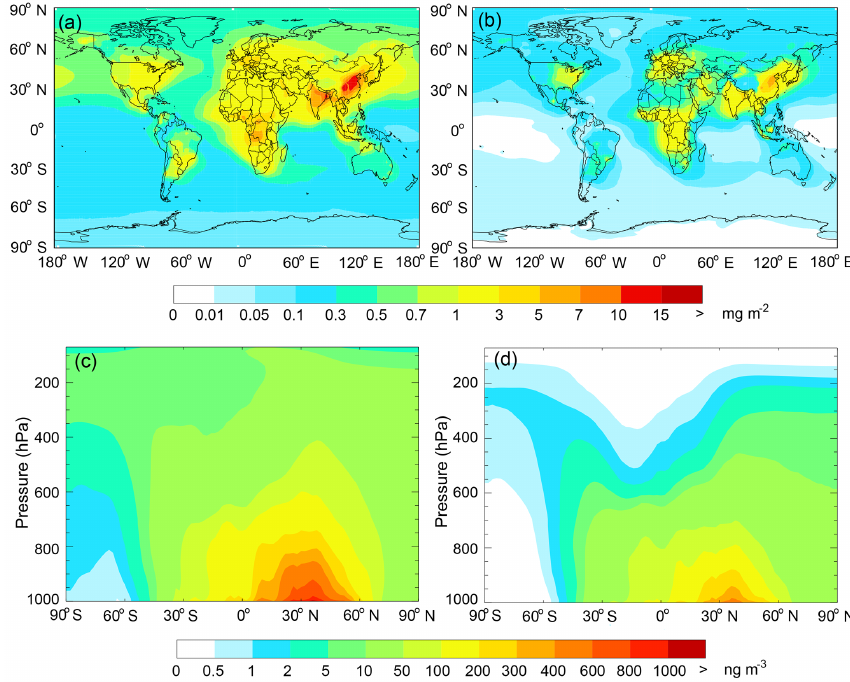
Figure 9. GEOS-Chem simulated annual mean BC column burden (mgm − 2 ) (top panels) and zonal mean BC concentrations (ngm − 3 ) (lower panels) using a fixed BC aging scheme (left panels) and a microphysics-based aging scheme (right panels). Model results are for 2009.